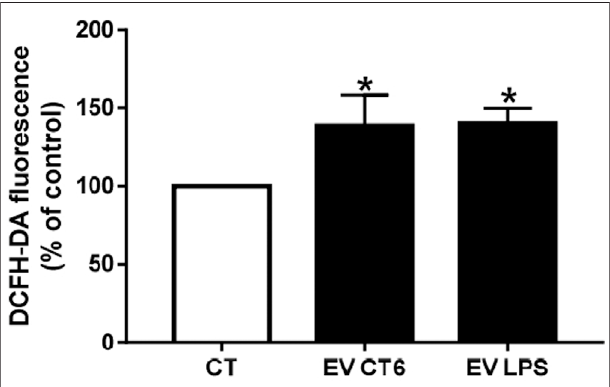
FIGURE 8 | Macrophage-derived EVs induce ROS production in smoothmusclecells.MOVAS-1cellswereincubatedwith10 µMDCFH-DAin D-PBS at 37 ° C for 30 min and then treated with macrophage-derived EVs for 24 h. ROS production was determined by measuring fl uorescence ( λ Ex 492 nm, λ Em 535 nm). ROS production by untreated control cells (CT) was de fi nedas100%.Dataareexpressedasthemean±SEMoffourindependent experiments performed in triplicate ( n = 4). * p < 0.05 vs . CT, Mann-Whitney test. EV-CT: EV-derived from untreated macrophages, EV-LPS: EV-derived from LPS-EK-treated macrophages.